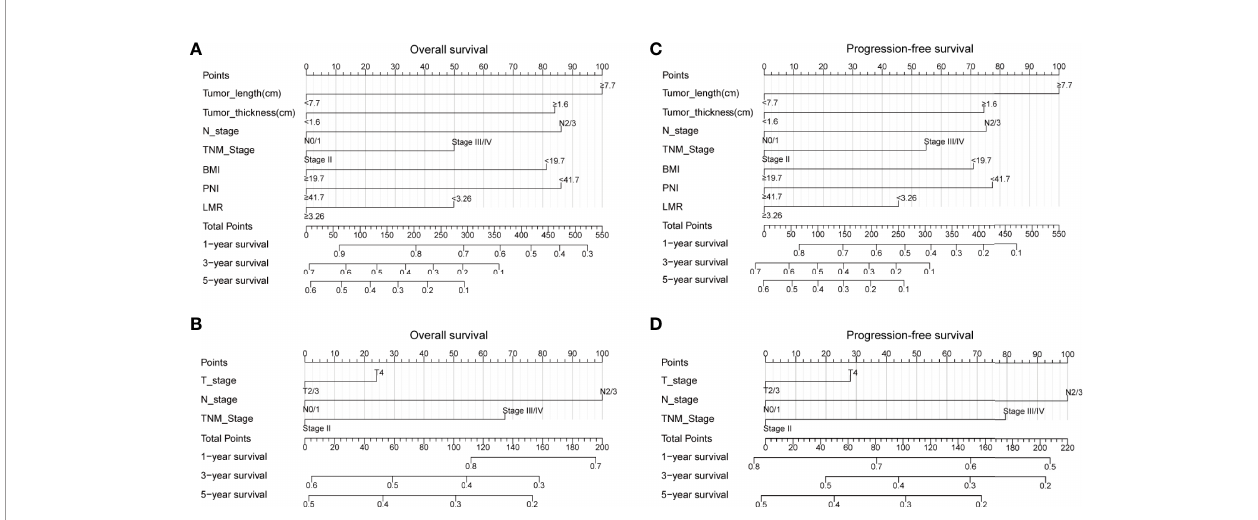
FIGURE 1 | Nomogram for predicting the probability of 1-, 3-, and 5-year OS and PFS for the whole study population. (A) A nomogram that integrates tumor length, tumor thickness, N stage, TNM stage, BMI, PNI, and LMR for OS in ESCC patients; (B) A nomogram that integrates T stage, N stage, and TNM stage for OS in ESCC patients; (C) A nomogram that integrates tumor length, tumor thickness, N stage, TNM stage, BMI, PNI, and LMR for PFS in ESCC patients; (D) A nomogram that integrates T stage, N stage, and TNM stage for PFS in ESCC patients. OS, overall survival; PFS, progression-free survival; T, tumor; N, node; TNM, tumor- node-metastasis; BMI, body mass index; PNI, prognostic nutrition index; LMR, lymphocyte-to-monocyte ratio; ESCC, esophageal squamous cell